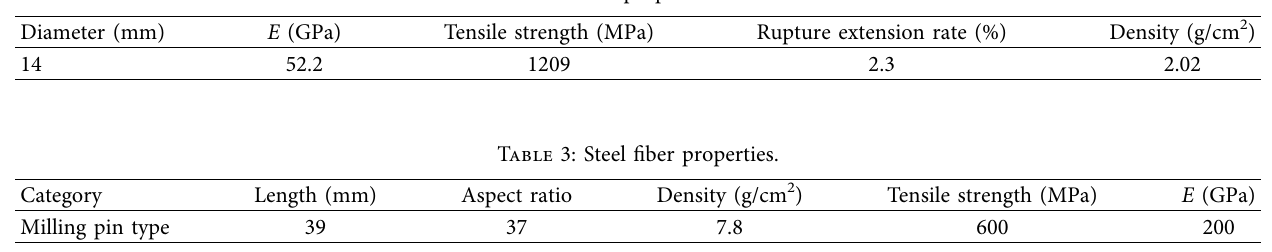
Table 2: Mechanical properties of BFRP